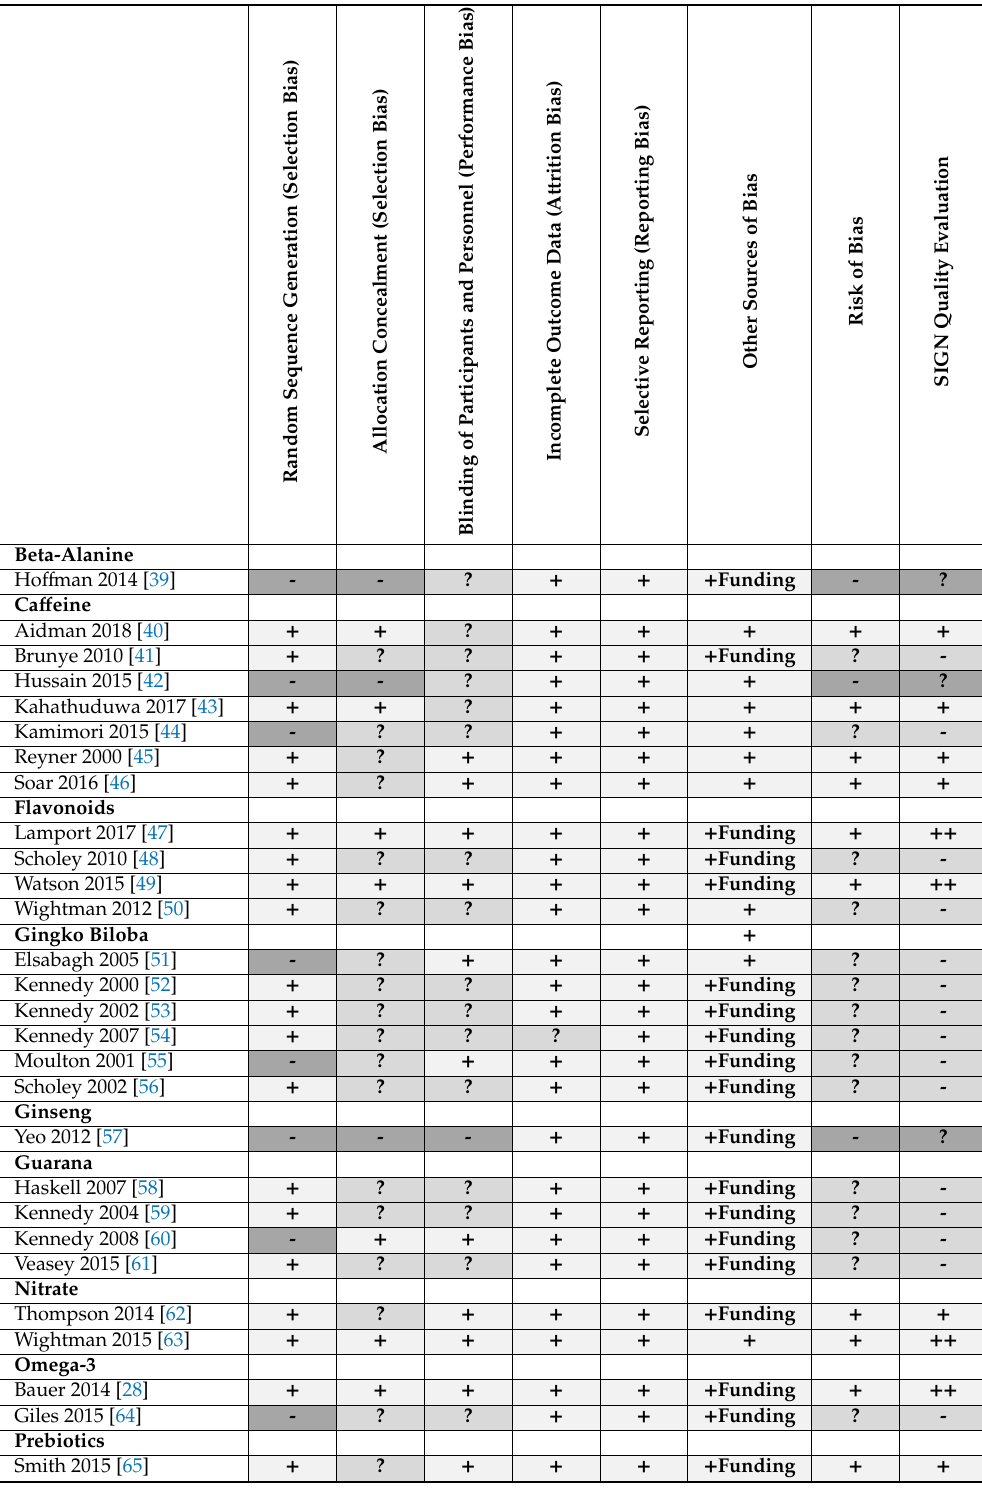
Table 2. Grading of Recommendations, Assessment, Development and Evaluation (GRADE) risk of bias and Scottish Intercollegiate Guidelines Network (SIGN) quality of randomised controlled trials